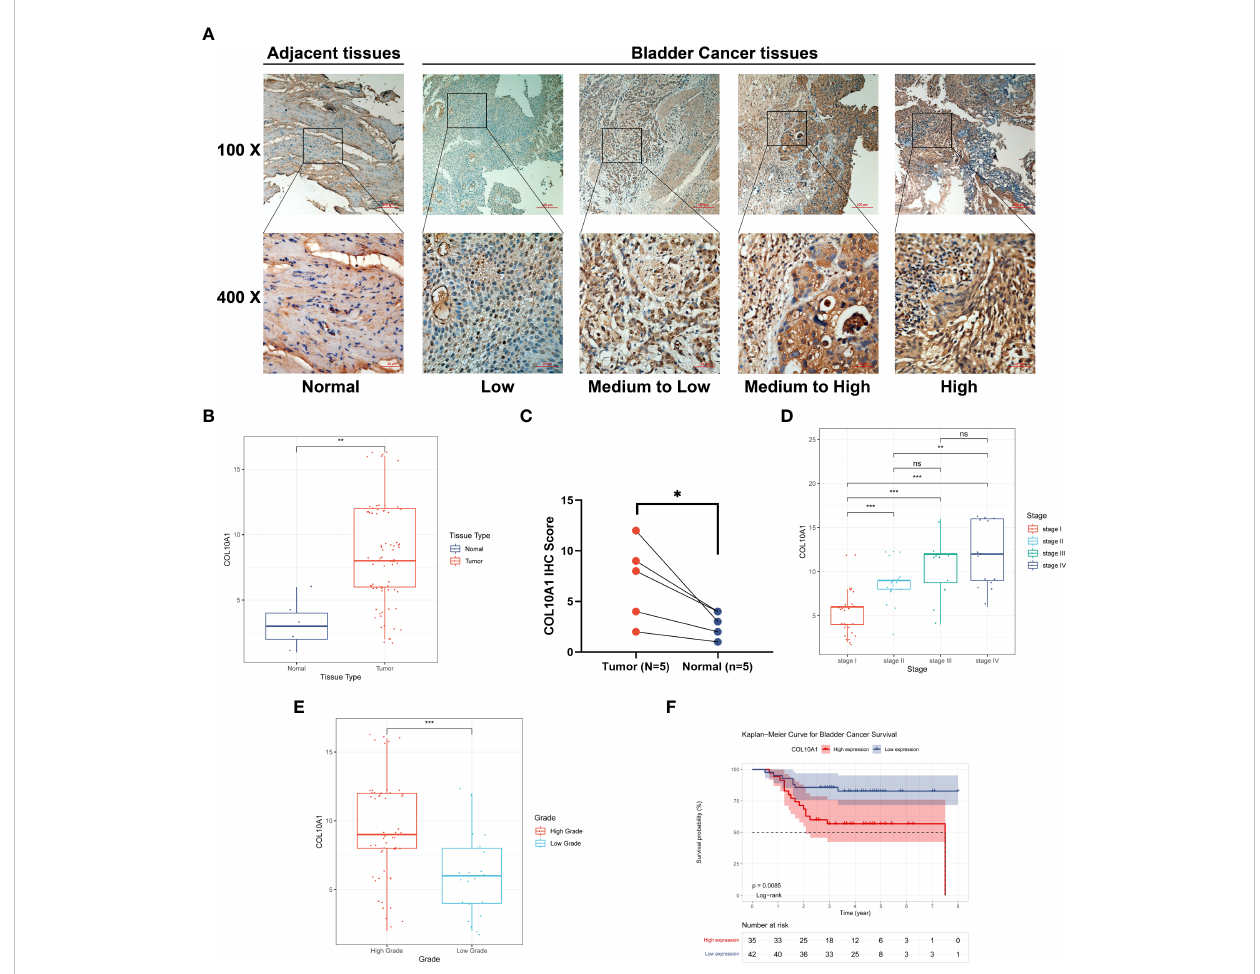
FIGURE 3 Validation of the increased expression of COL10A1 and prognostic value in 77-patients cohort. (A) Representative IHC staining for COL10A1 in BLCA and normal tissues. Protein expression of COL10A1 based on IHC staining scores was signi fi cantly different in BLCA and adjacent normal tissues (B, C) , also in tumor grade subgroup (D) , and stage subgroup (E) . Kaplan – Meier plot veri fi ed that high COL10A1 protein levels were associated with poorer survival outcomes in 77 BLCA patients (F) . * P < 0.05; ** P < 0.01; *** P < 0.001. ns, not signi fi